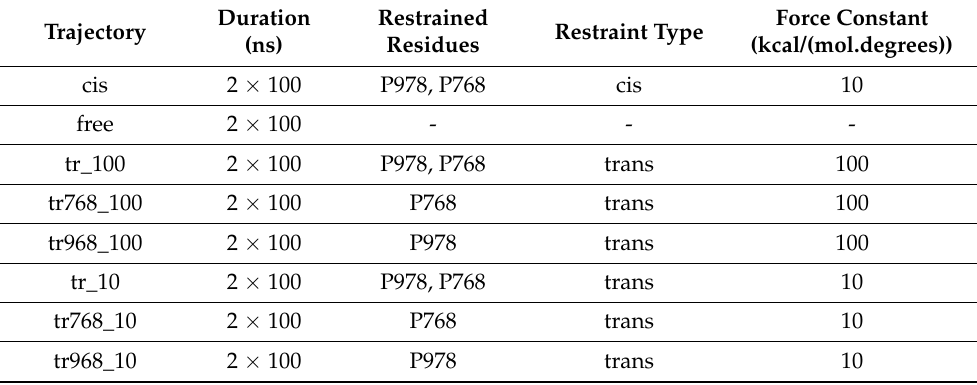
Table 1. Characteristics of MD